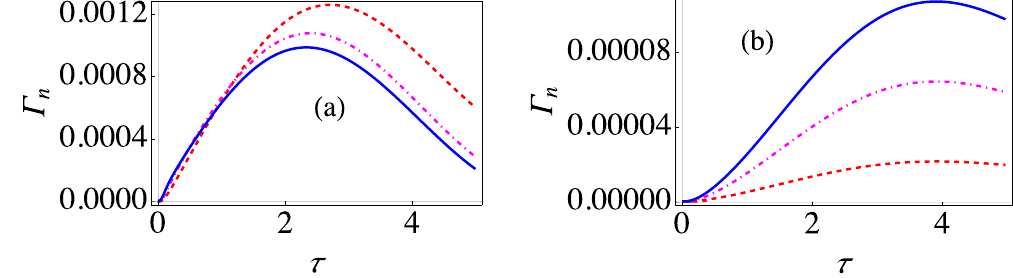
Figure 3. Dependence of the modified decay rate Γ τ ( ) on the system-environment coupling strength. ( a ) n Graph of the effective decay rate Γ τ ( ) (at zero temperature) in the strong system-environment coupling regime n as a function of τ with the system-environment coupling strength G = 1 (red, dashed curve), G = 1.75 (dot- dashed, magenta curve), and G = 2.5 (solid, blue curve). Here we have used an Ohmic environment ( =